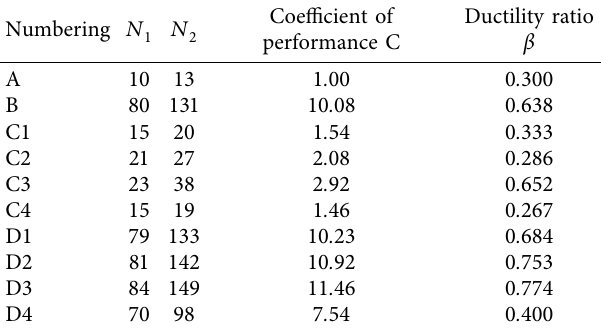
Table 4: Toughness coefficient and ductility ratio test